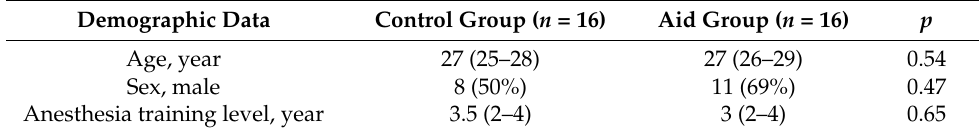
Table 1. Demographic data of the anesthesia residents included in the study.